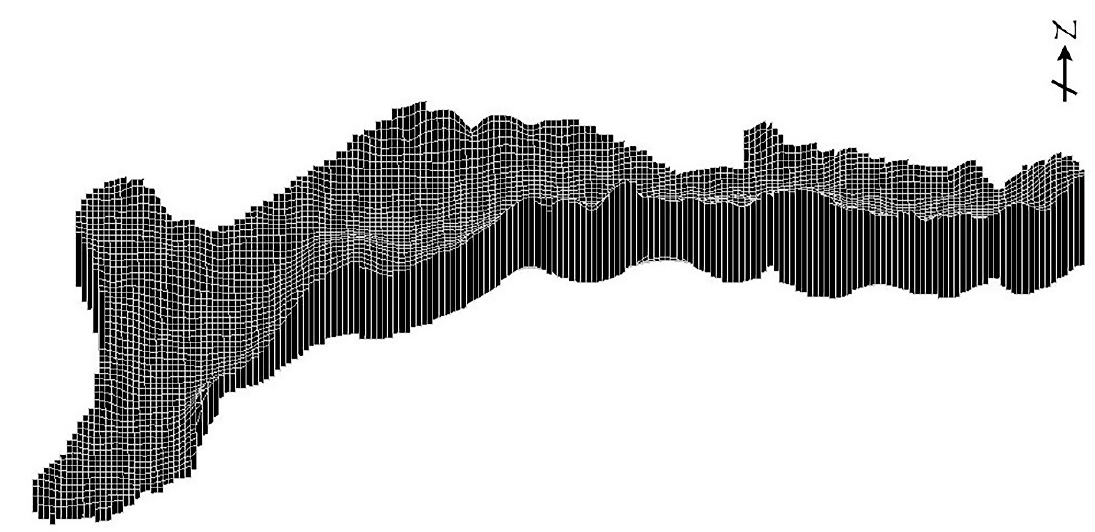
Figure 14. 3-D grid created by GMS: MODFLOW for Birjand groundwater model.